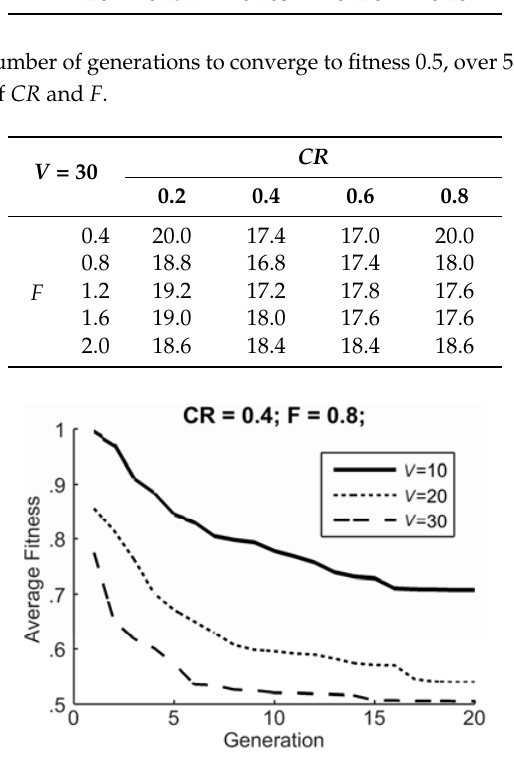
Figure A1. The average fitness of the population against the generation.